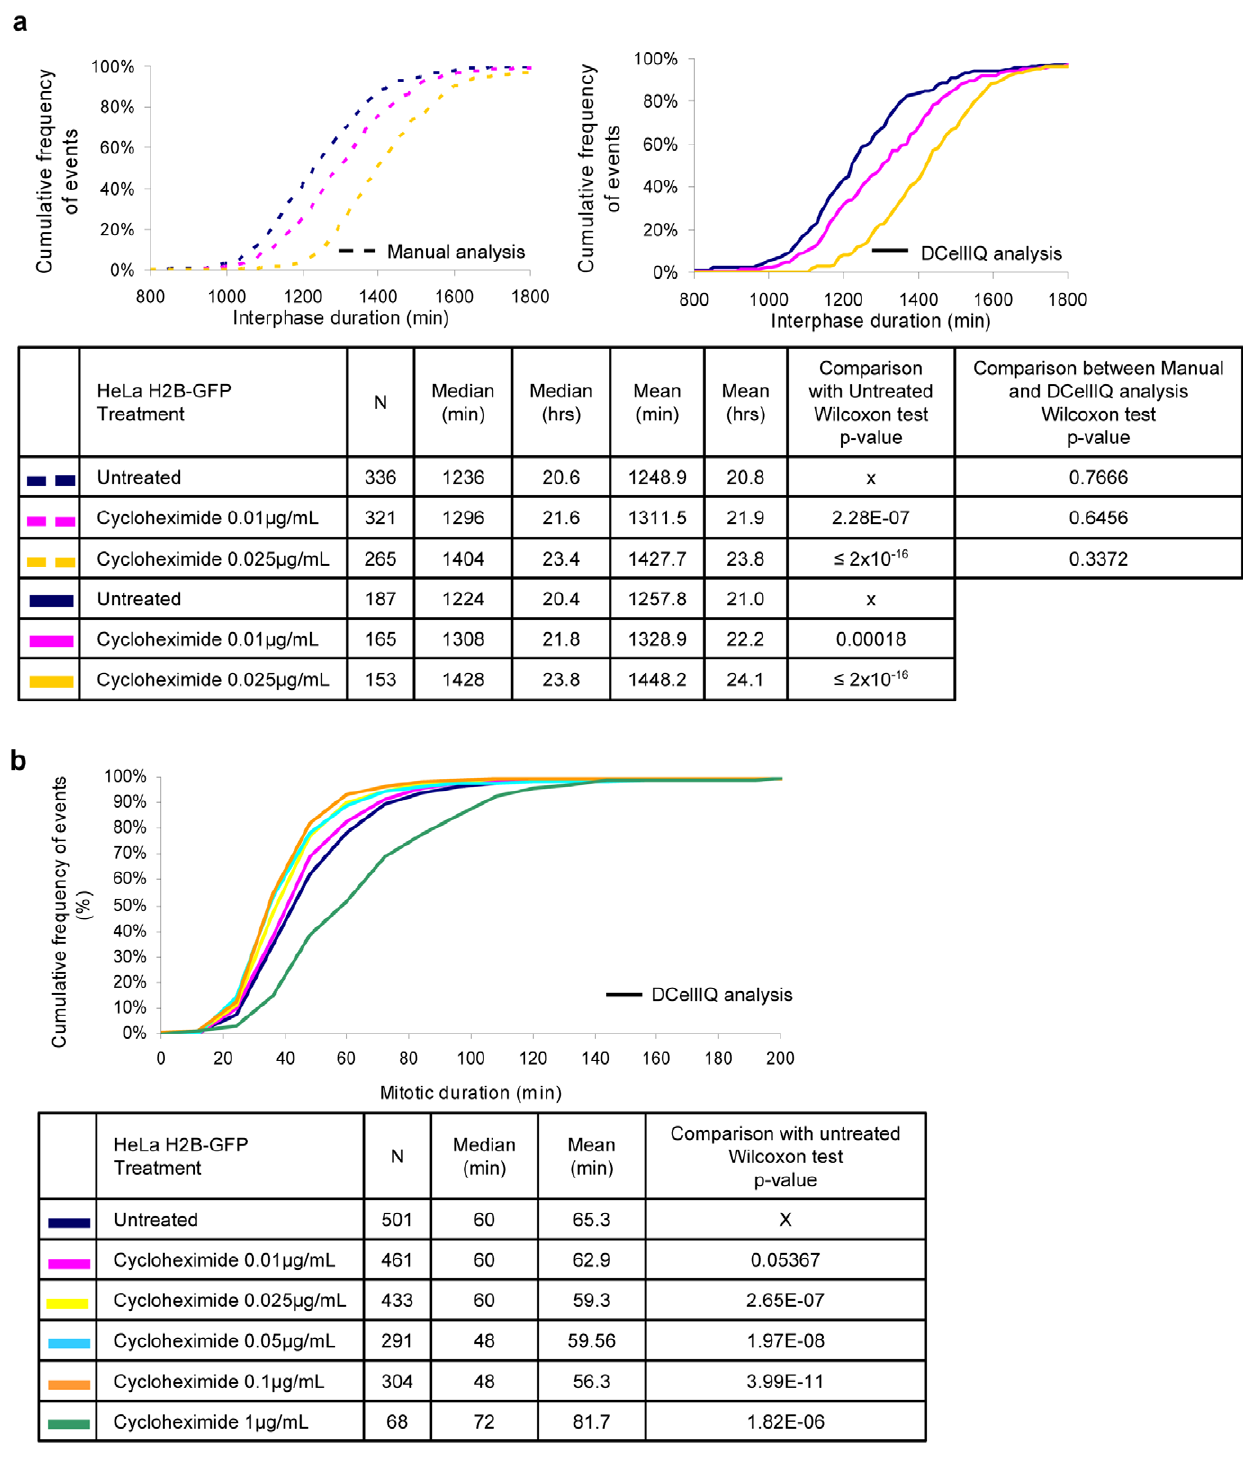
Figure 6. TSA detects changes in interphase and mitotic durations in response to cycloheximide treatment. HeLa H2B-GFP cells were treated with cycloheximide at indicated concentrations. Cells were imaged every 12 min for 48 hours. For each condition, 4 fields in 2 independent wells were imaged and the results for the 8 image series were combined. Image series were analyzed using DC ELL IQ (a and b) with the time series approach and half of them were analyzed manually (a). The origin of x-axis in graph (a) was set at 800 minutes as no interphase events had a duration shorter than 800 minutes.